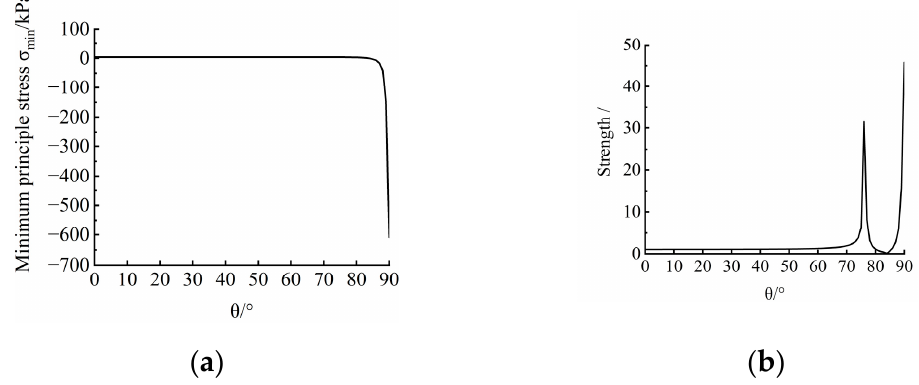
Figure 11. Phase III ( β ≈ 90 ◦ ). ( a ) Distribution of minimum principal stress; ( b ) distribution Figure 11. Phase Ⅲ ( β ≈ 90° ) . ( a ) Distribution of minimum principal stress; ( b ) distribution of of strength.